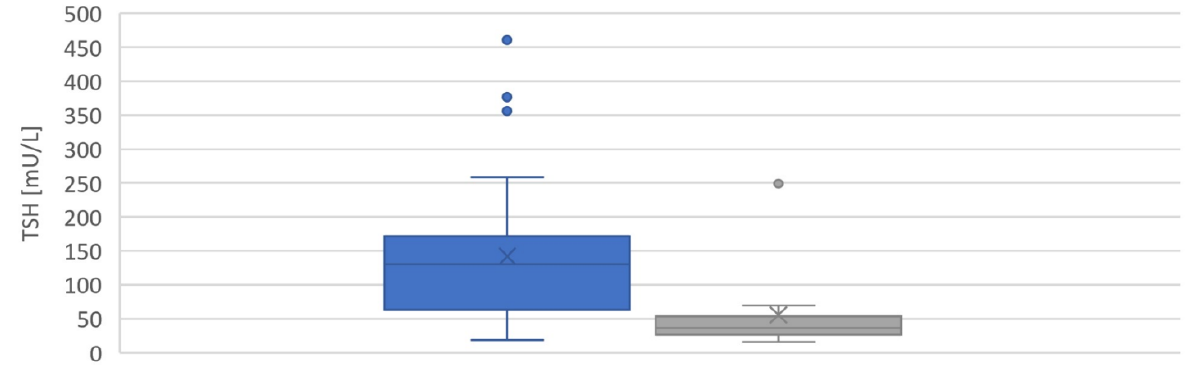
Figure 4. Distribution of family history in patients with CH. ■ Positive family history. ■ Negative family history. ■ Family history not recorded.